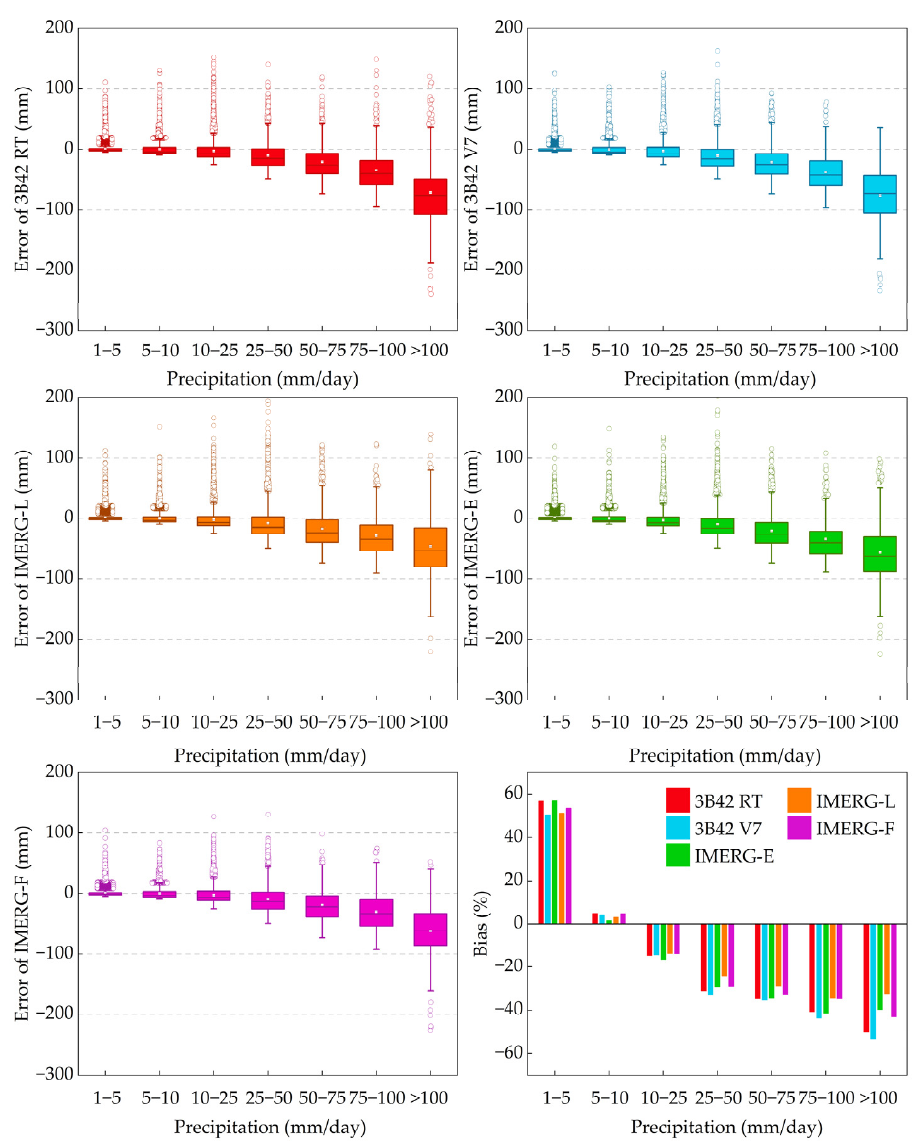
Figure 3. Boxplots of the five SPPs and the observed precipitation at different precipitation intensities. The upper and lower edges of the box mark the upper and lower quartiles (75% and 25%, respectively); the solid line in the box marks the median value; the upper and lower horizontal lines outside of the box mark the range in 1.5 IQR; the square point marks the average value; and the circular points mark the